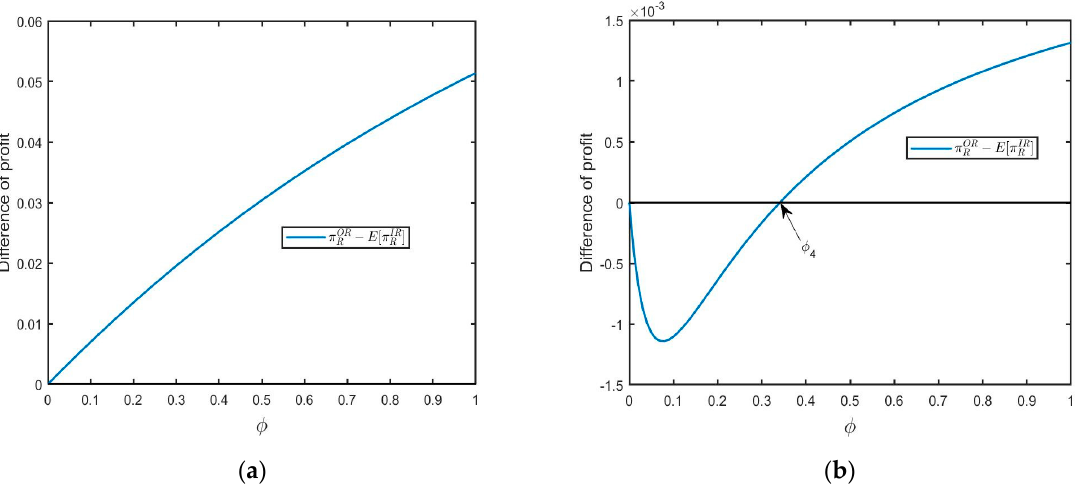
Figure 3 . The impact of φ on profit difference: ( a )